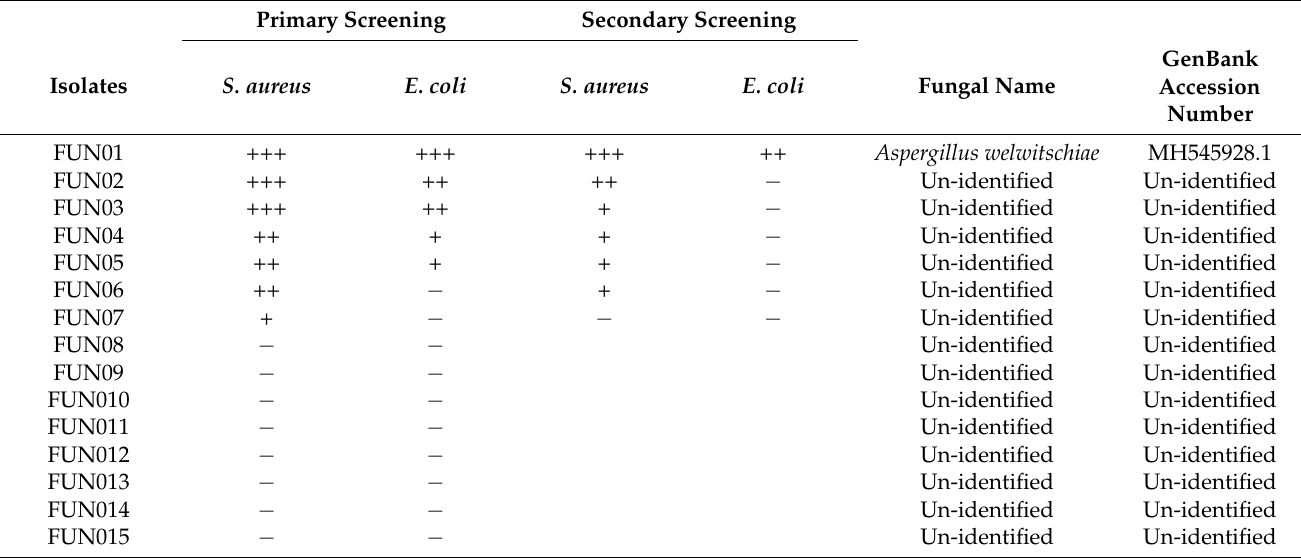
Table 1. Zones of inhibition obtained during the screening of the production of the production of antimicrobial agents by the isolates and their